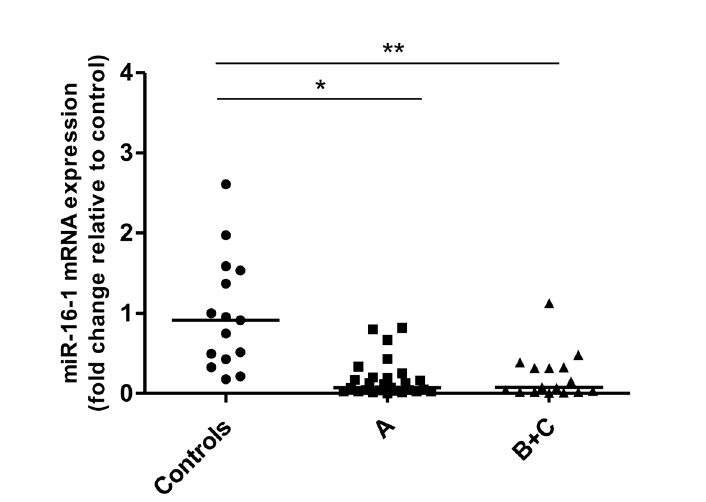
FIGURE 2 - miR-16-1 mRNA gene expression in the Controls, CLL Binet A (A) and Binet B+C (B+C). *p<0.001: A versus controls. **p<0.001: B+C versus controls. No significant difference was found when comparing Binet A and Binet B+C. Data was presented as median values generated by ANOVA, followed by the Kruskal-Wallis test.